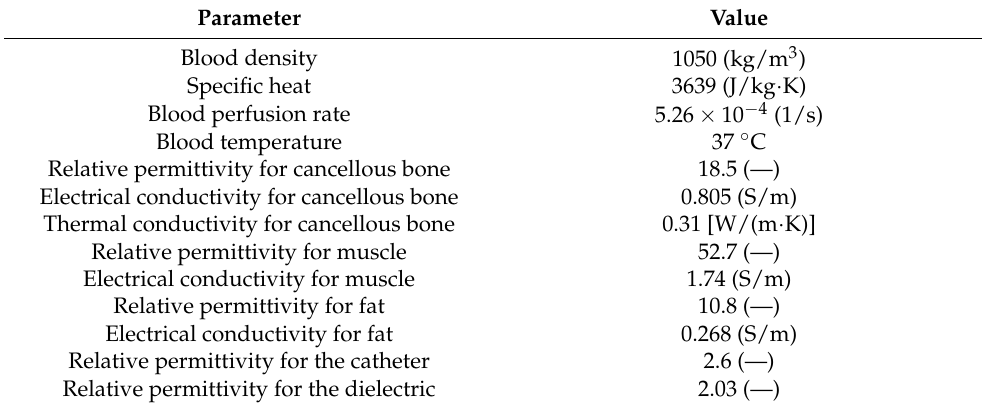
Table 1. Dielectric and thermal properties, for the tissues and antennas, used in the